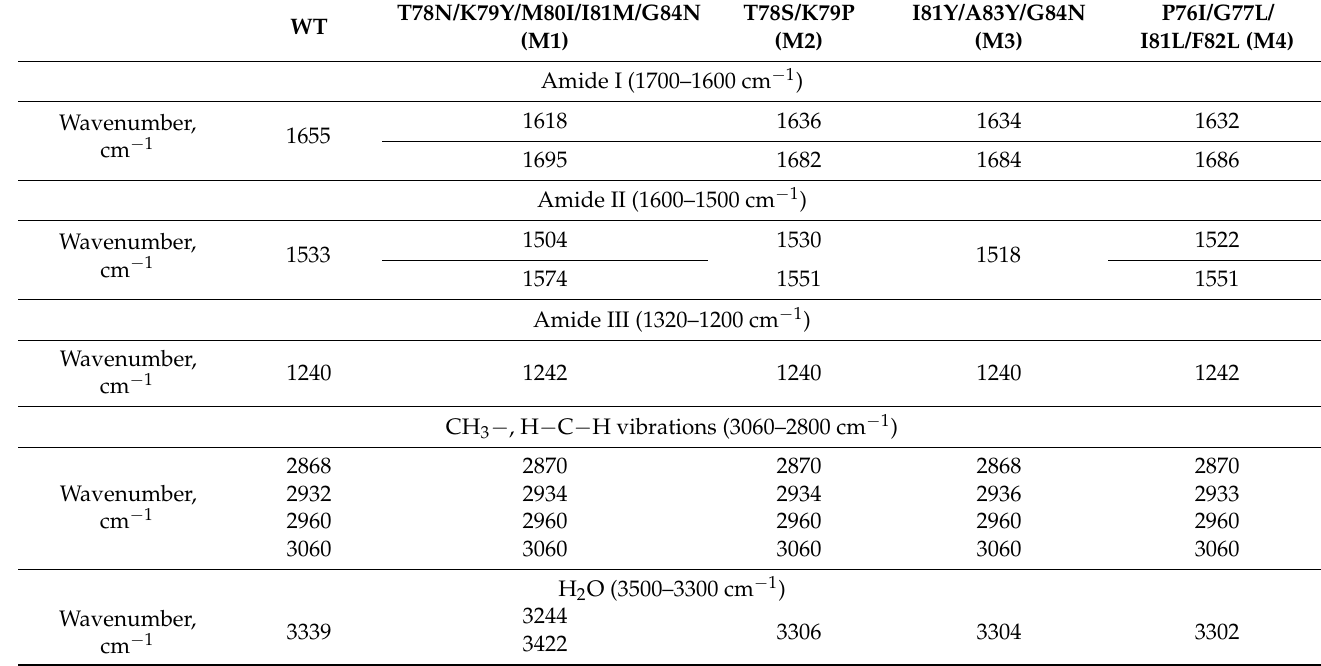
Table 2. Analysis data of the IR spectra of cytochrome c (WT) and its mutant